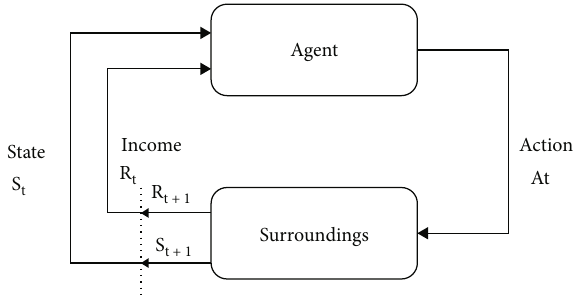
Figure 3: RL agent environment interaction model.